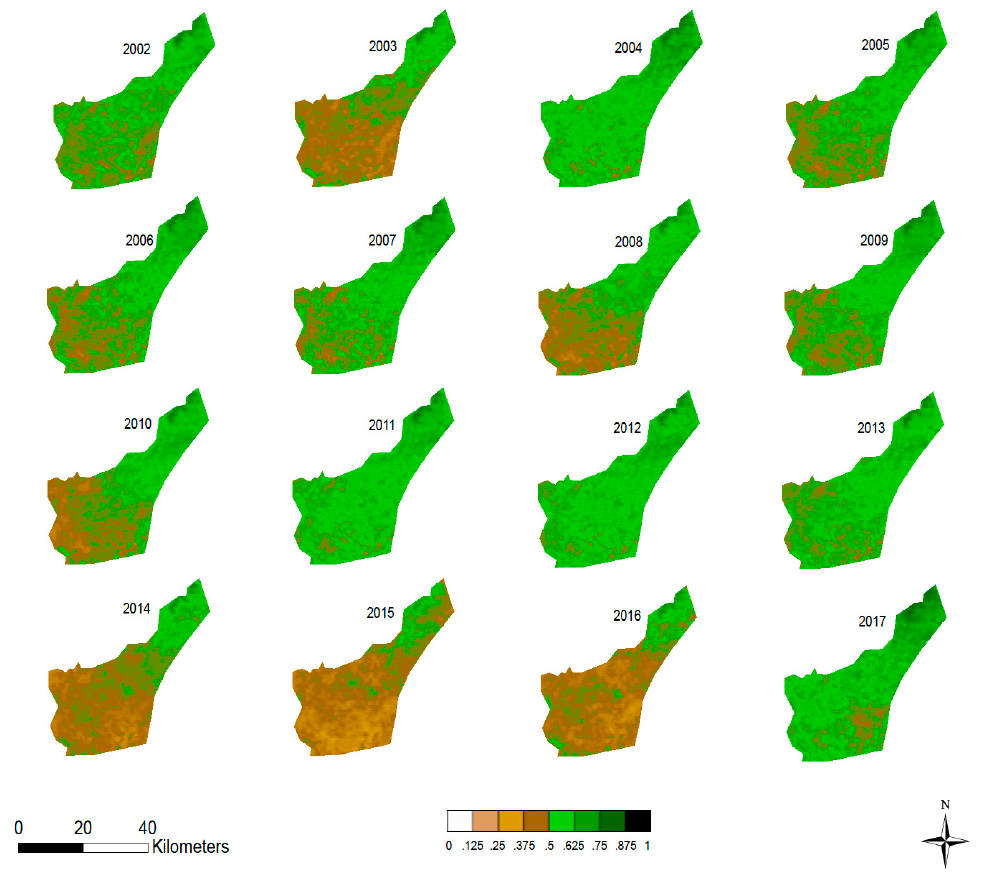
Figure 3. The spatiotemporal variability of normalized difference vegetation index (NDVI) at the Hluhluwe-iMfolozi Park for the period from 2002 to 2017. The scale represents the range of NDVI values from 0 to 1.